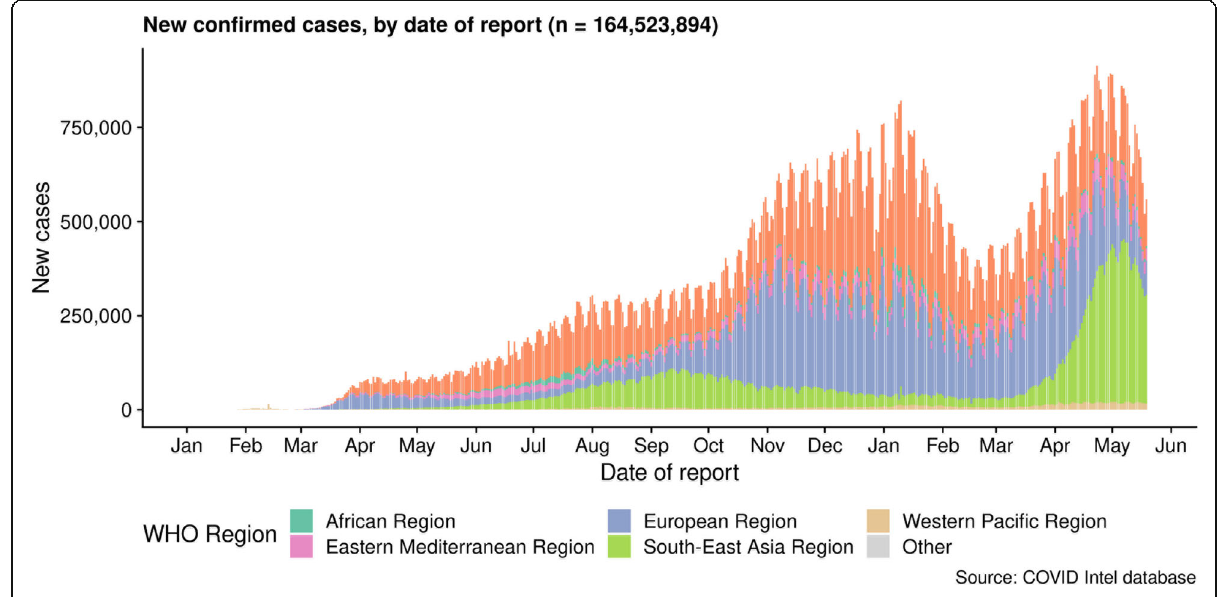
Fig. 2 The reported covid-19 cases all over the world (WHO Case study)